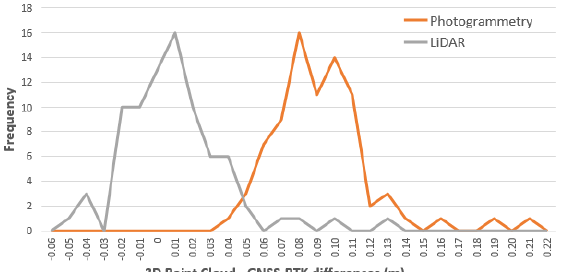
Figure 7: Histogram analysis of the height differences between the photogrammetry (AT) and LiDAR 3D point clouds against the GNSS-RTK CPs.